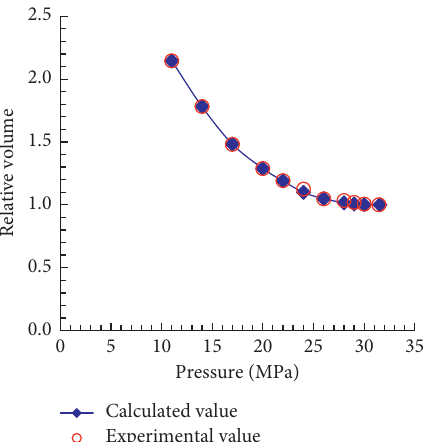
Figure 10: Comparison for sample 3 of calculated and experi- mental relationship diagram between relative volume and pressure.